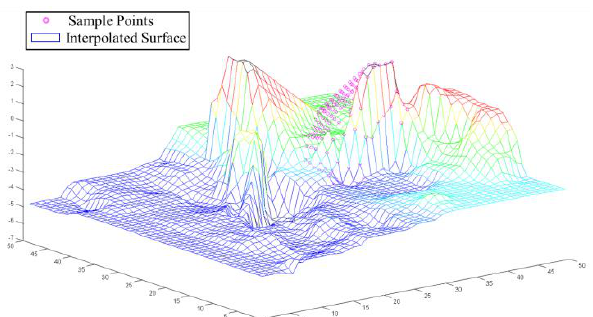
Figure 3. The interpolated surface and abnormal displacement position Handling the displacement with a post-processing, only the geometric position of the original sensed image is changed to align to the reference image and the surface of aligned image is consistent with the original sensed image as in Figure 2.(e).